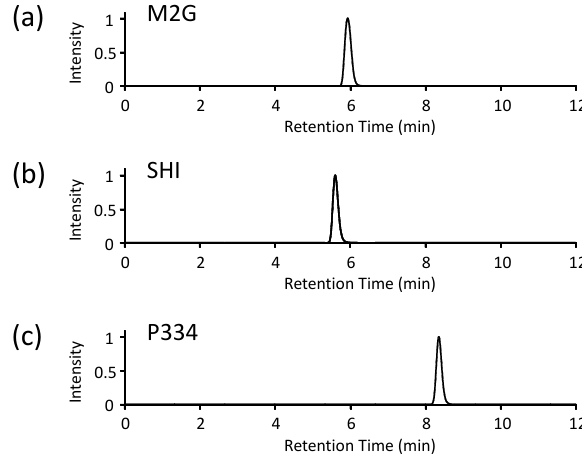
Figure 3. Analytical high performance liquid chromatography (HPLC) profiles of ( a ) M2G, ( b ) SHI, and ( c ) P334. The retention times of M2G, SHI, and P334 were 5.9, 5.6, and 8.4 min, respectively. The molecular structures of these purified MAAs were confirmed by NMR analysis. The NMR data is shown below.